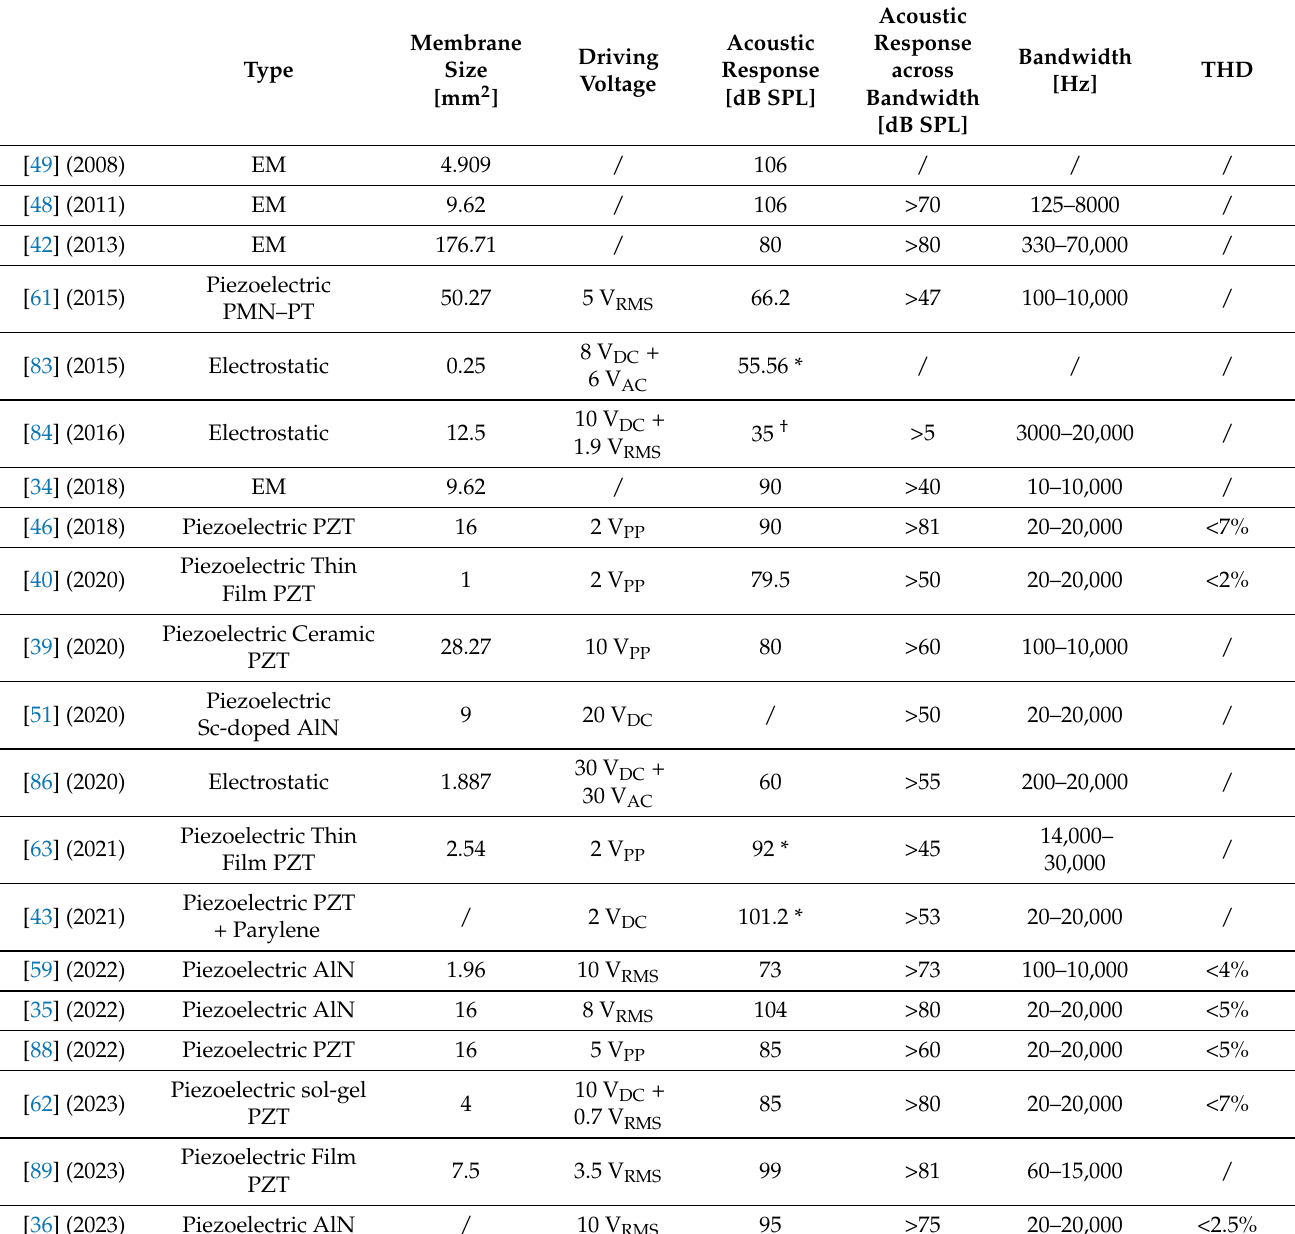
Table 2. Summary of state-of-the-art MEMS